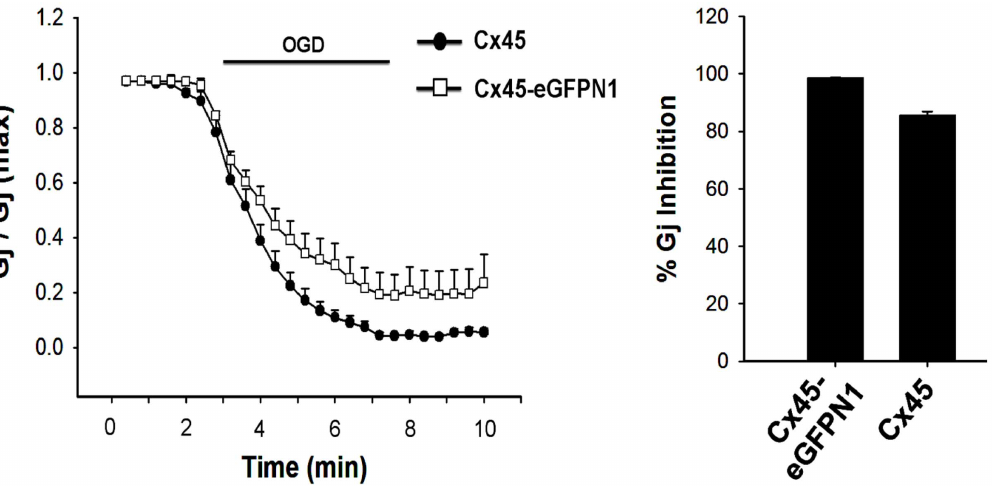
Figure 3. OGD inhibited Cx45-eGFP more than Cx45. OGD uncoupled eGFP tagged Cx45 almost completely, compared to 85 6 2% inhibition in wild type Cx45. The difference is statistically significant (p , 0.001).